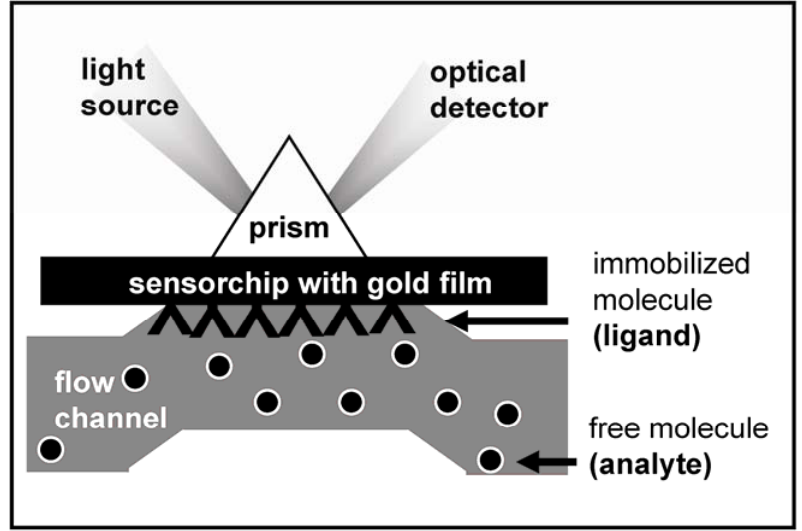
Figure 2. Schematic representation of SPR technology. The molecule immobilized onto the gold film of the sensor chip is named ligand whereas the analyte is represented by the putative partner injected into the microfluidic